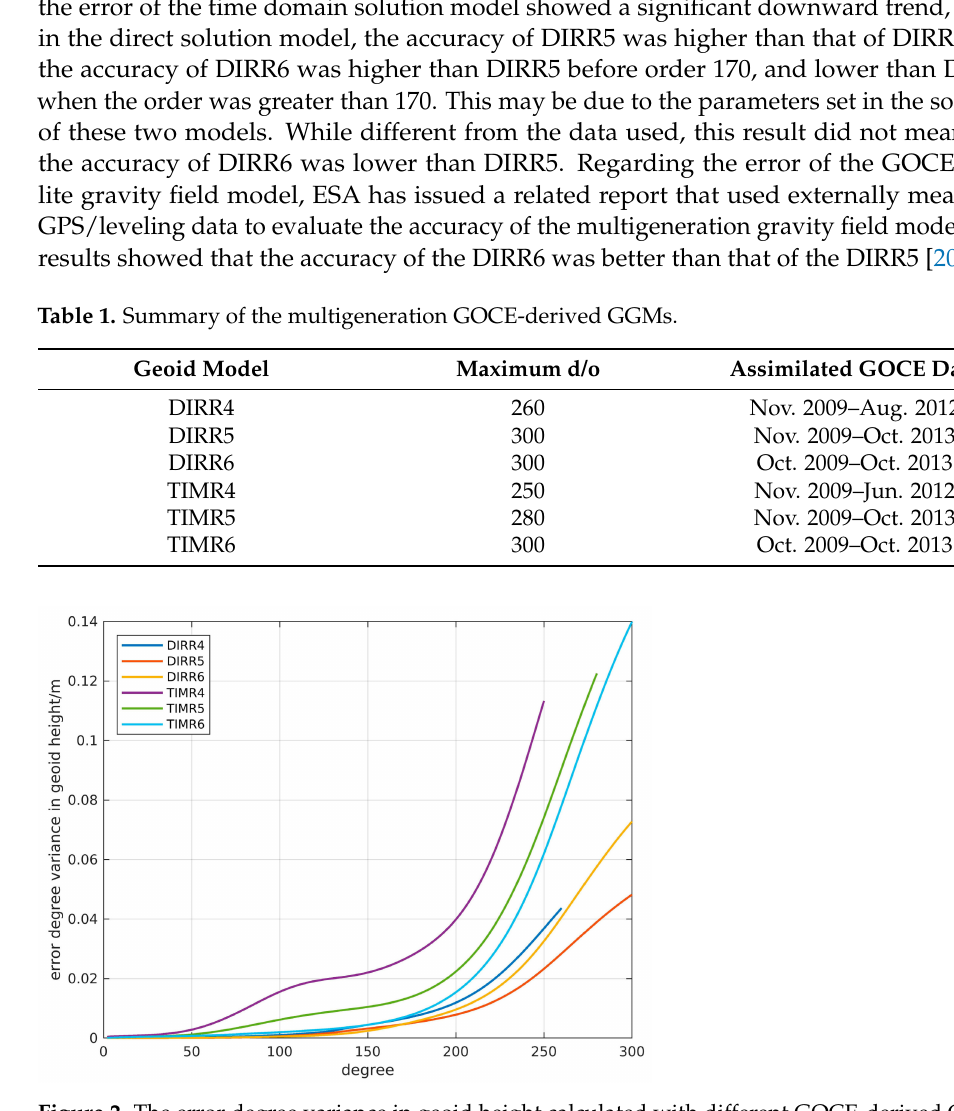
Figure 2. The error degree variance in geoid height calculated with different GOCE-derived